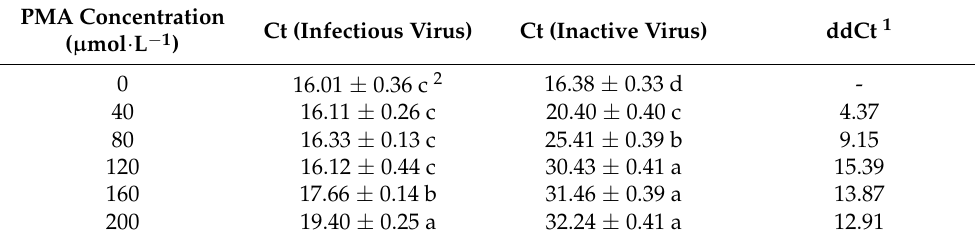
Table 2. Effect of PMA concentration on the amplification of RNA from infectious and inactive CGMMV. PMA Concentration Ct (Infectious ( µ mol · L − 1 )